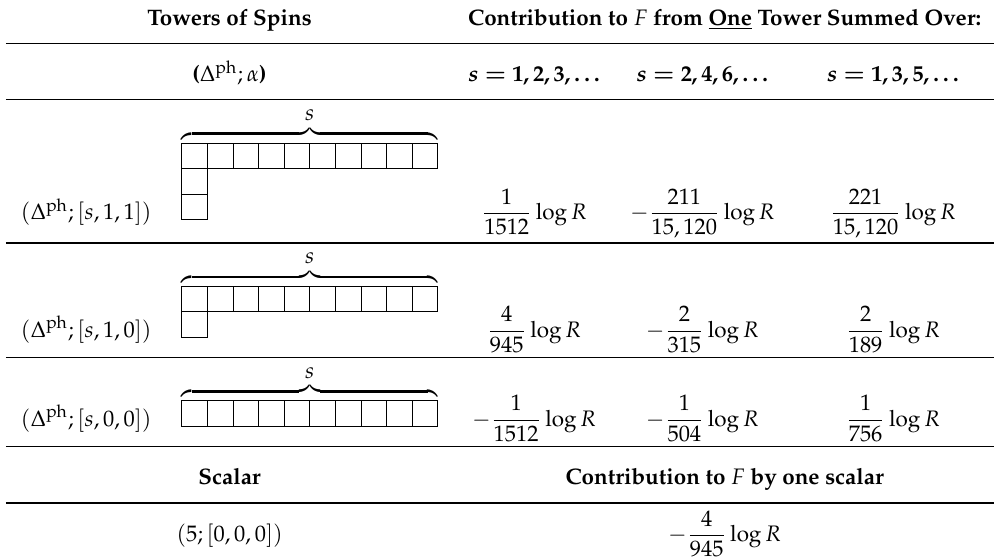
Table A5. Results for Type B theory in AdS 9